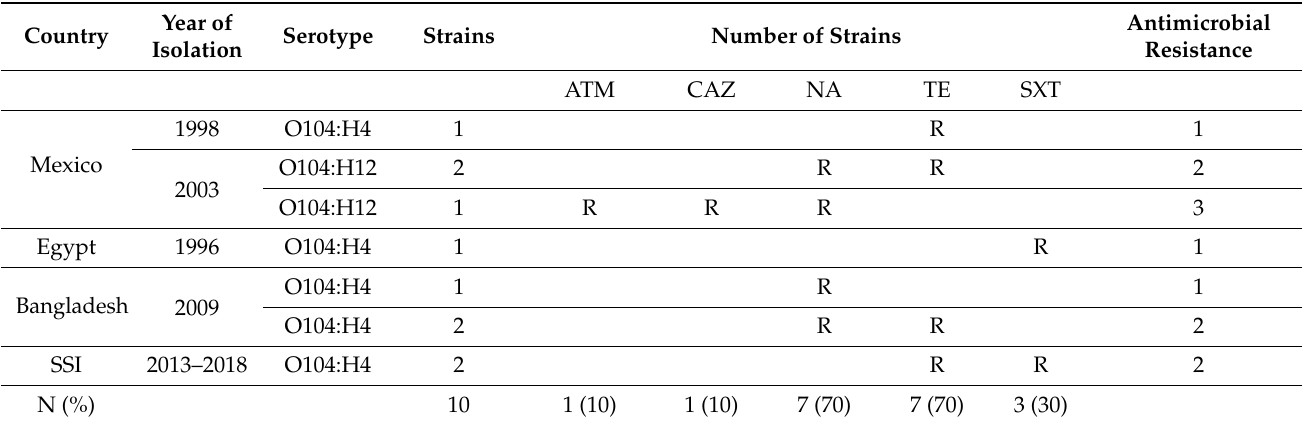
Table 5. Resistance patters of E . coli O104 strains.